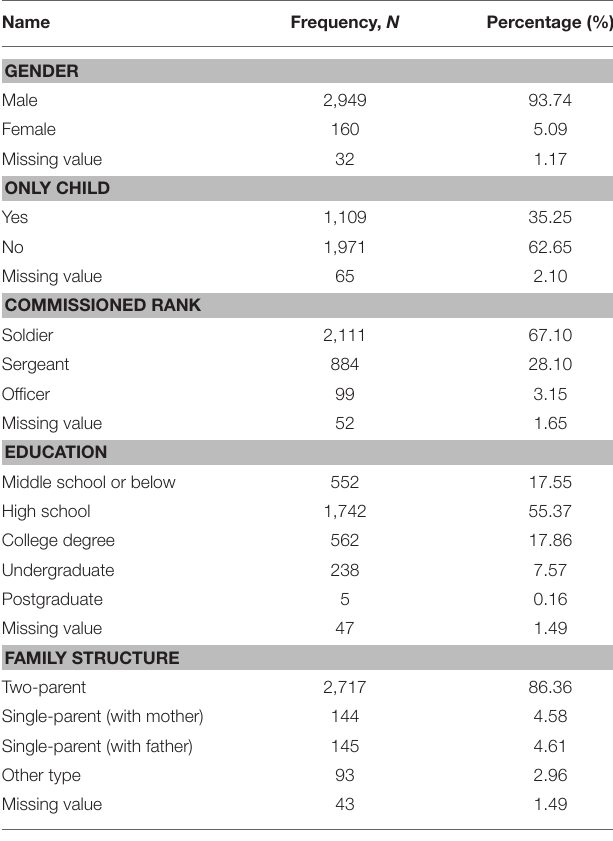
TABLE 1 | Demographic characteristics of Chinese military men sample.